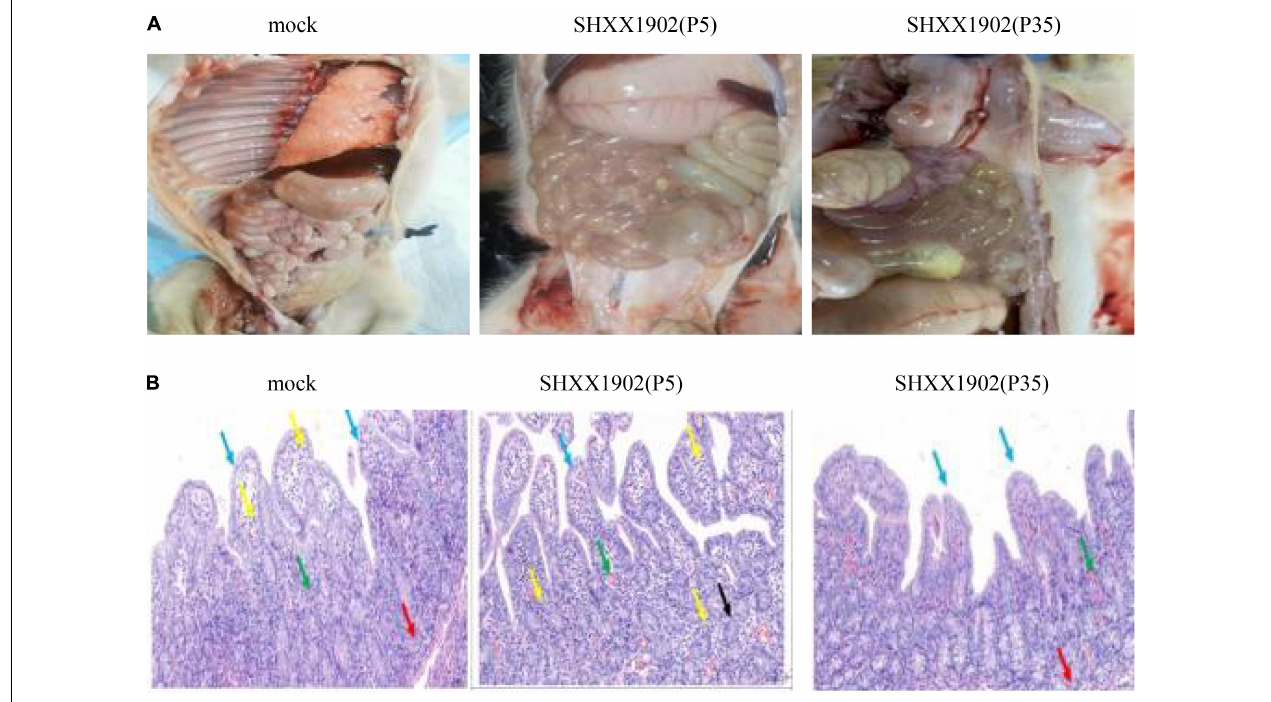
FIGURE 4 | Histopathological analysis. (A) Comparison of small intestinal lesions in different groups (mock, P5, and P35) at necropsy at 3 dpi. (B) Hematoxylin-and-eosin-stained jejunum tissue sections from the different groups at 3 dpi.